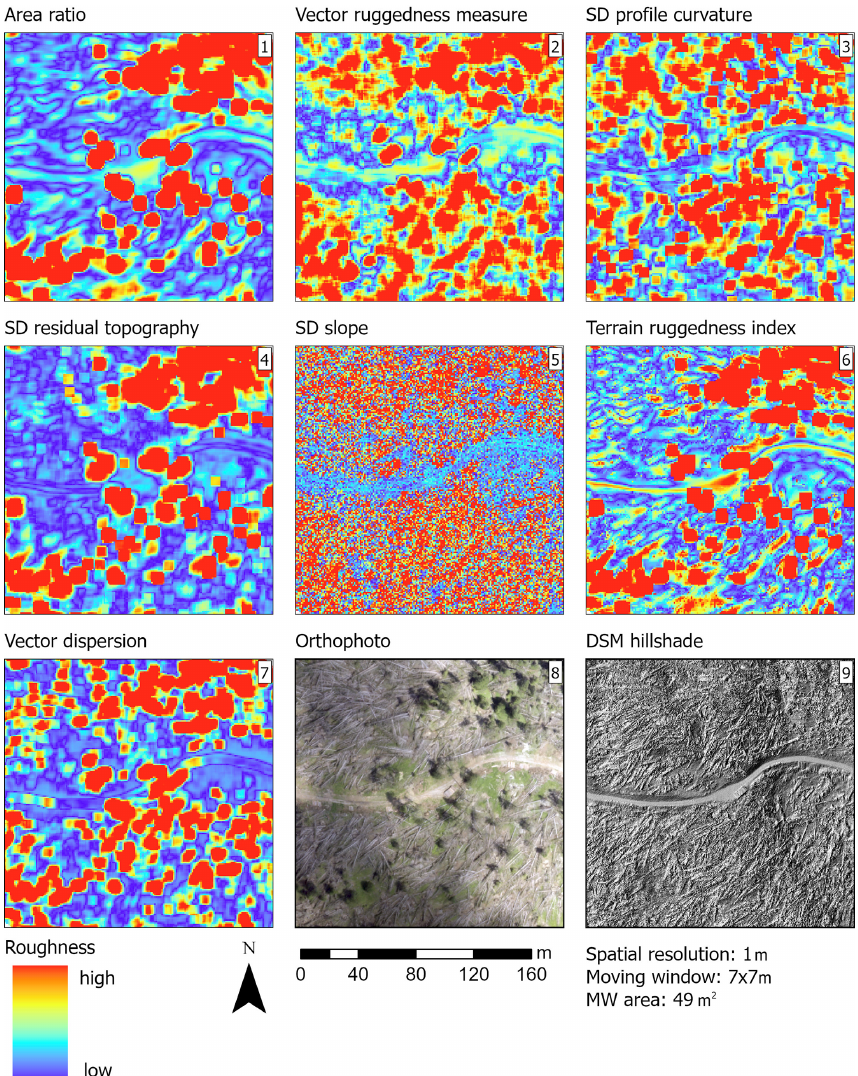
Figure A3. Calculated surface roughness in the study area Franza using the seven investigated algorithms: area ratio (1) , vector ruggedness measure (2) , SD of profile curvature (3) , SD of residual topography (4) , SD of slope (5) , terrain ruggedness index (6) and vector dispersion (7) . The same area is presented as an orthophoto (8) (drone flight, 2019) and in DSM hillshade (9) (lidar data provided by the region Veneto). All algorithms were calculated based on the overall best performing combination of spatial resolution (1m) and neighbourhood (moving window 7 × 7m). To improve the visualisation and compare the roughness maps, we normalised them with the 25th percentile as the minimum value and the 75th percentile as the maximum